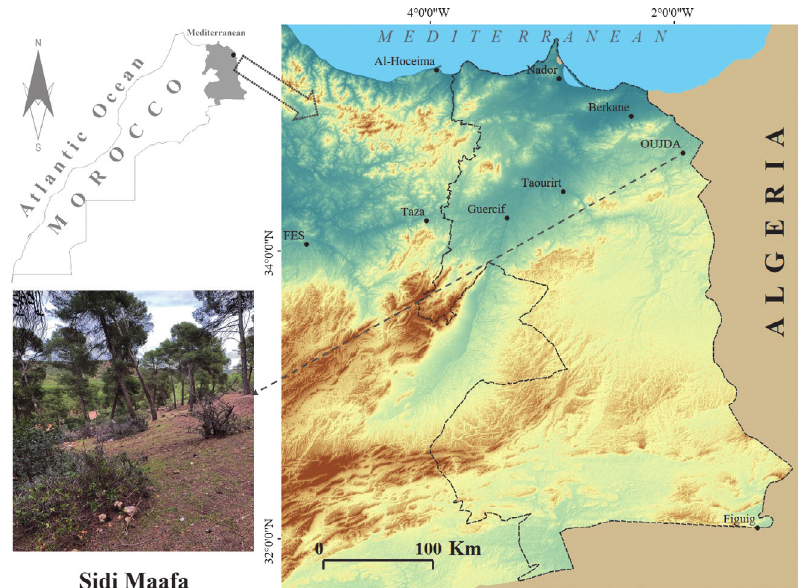
Figure 1. Location of the Oriental region in Morocco and type habitat of Sidi Maafa